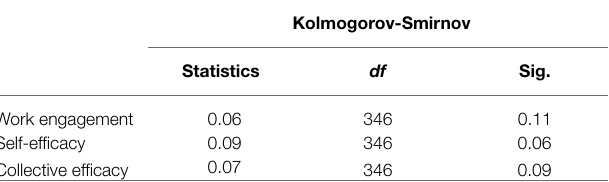
TABLE 2 | The results of KS